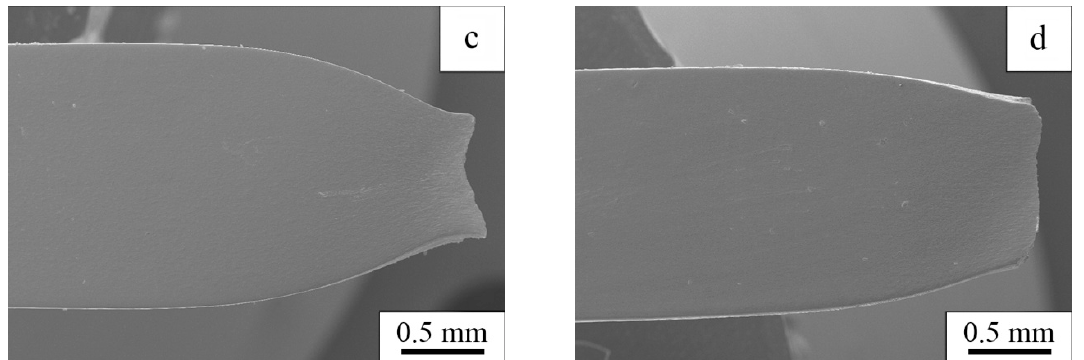
Figure 8. Fracture area of samples of the ( a ) FG Zr–1Nb, ( b ) FG Zr–1Nb–0.33H, ( c ) UFG Zr–1Nb, and ( d ) UFG Zr–1Nb–0.33H alloys after tension at temperatures of 293 K.